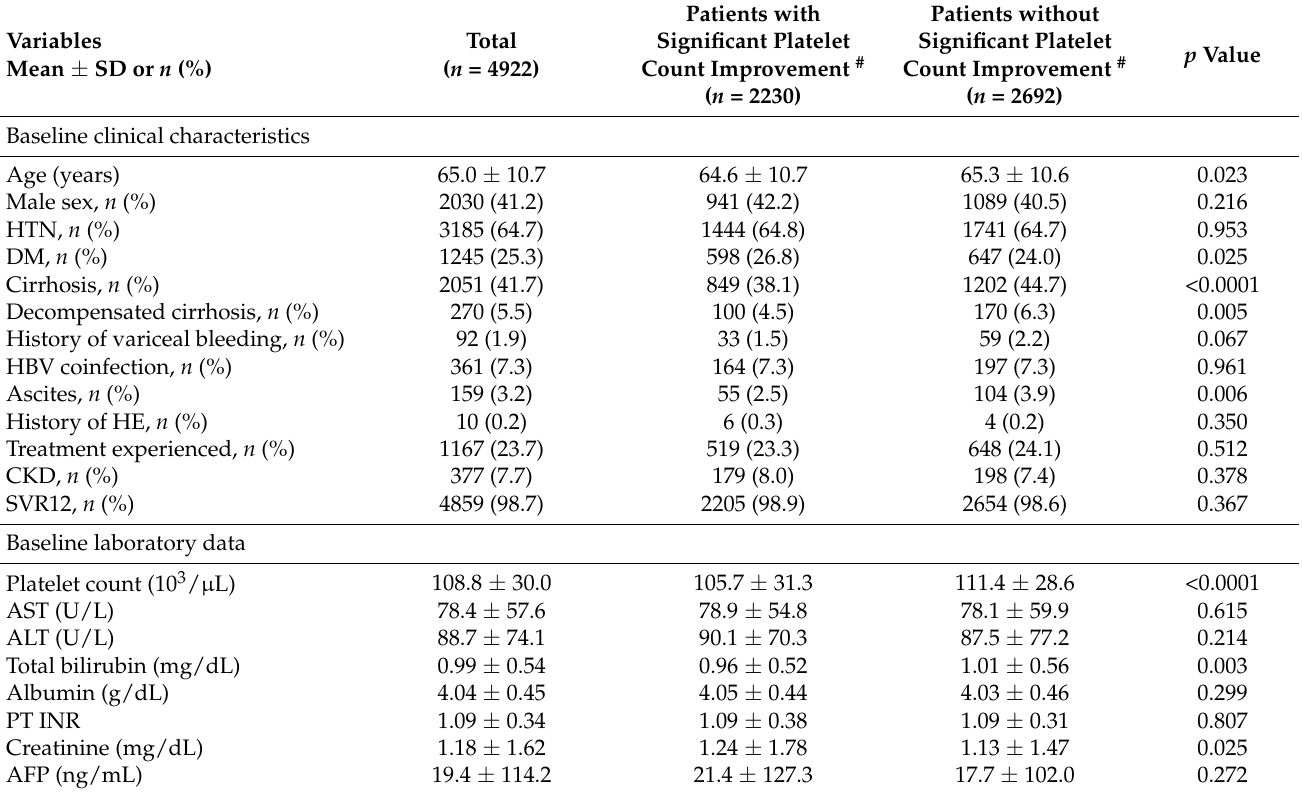
Table 1. Baseline characteristics of the thrombocytopenic HCV patients with or without significant platelet count improvement after DAA